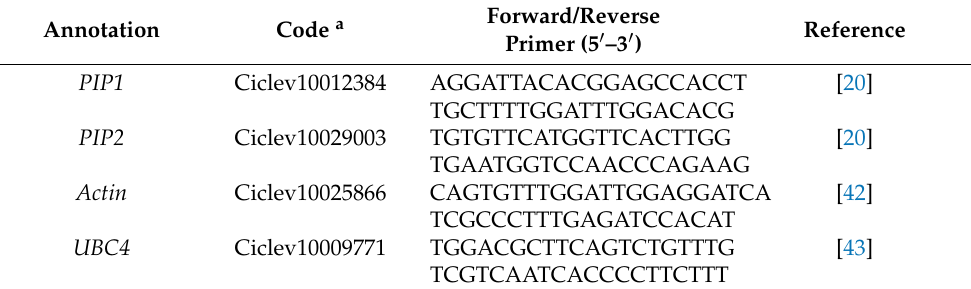
Table 1. List of the primers used for quantitative real-time